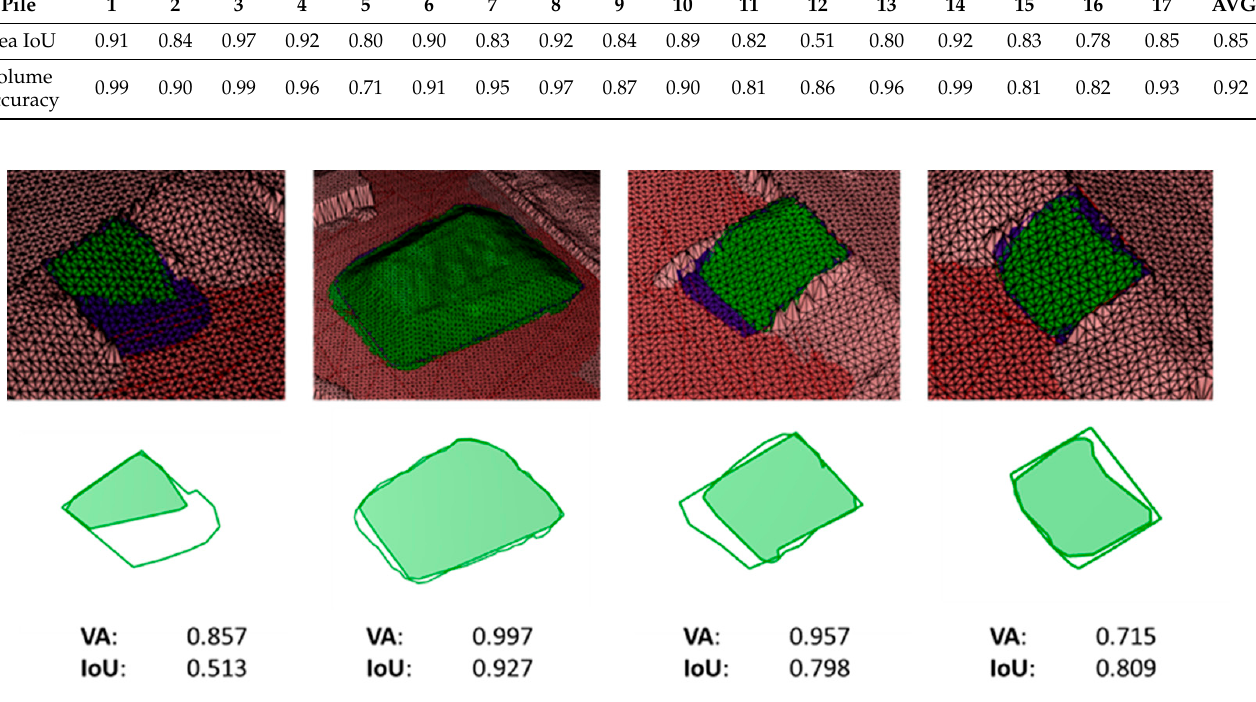
Figure 19. Prediction and ground truth projected on the surface scan (as